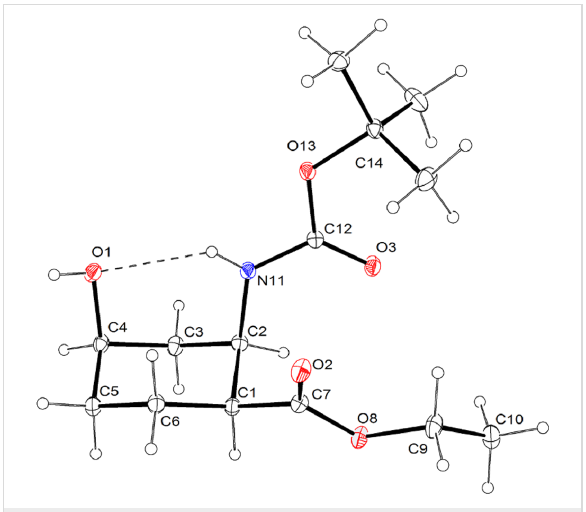
Figure 2: ORTEP diagram of hydroxylated amino ester 5 . Thermal ellipsoids have been drawn at the 20% probability level.